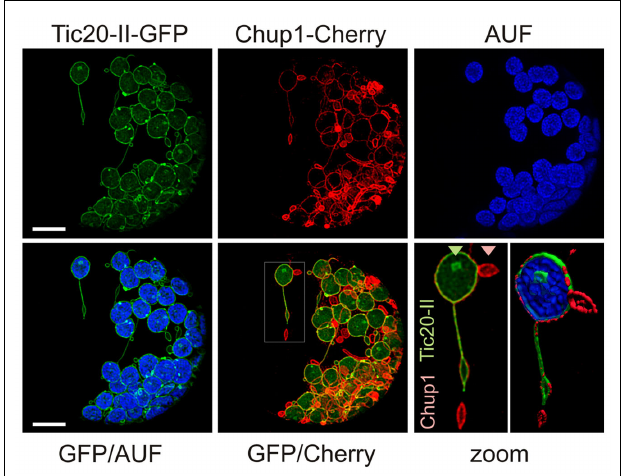
FIGURE 6 | Co-expression of outer and inner chloroplast membrane proteins at high levels induces many types of membrane alterations including stromule-like structures. A. thaliana mesophyll protoplasts were co-transfected with at Tic20-II–GFP (inner envelope) and TM-CHUP1–Cherry (outer envelope; see Figure 5E ). GFP fluorescence (GFP), Cherry fluorescence (Cherry), chlorophyll autofluorescence (AUF) or overlays of GFP/AUF and GFP/Cherry of a representative protoplast are shown. Images are maximum projections of optical sections.The scale bar represents 10 μ m.The framed region in the GFP/Cherry overlay is zoomed in bottom right (scale bare 2 μ m).The triangles point to labeling with GFP or Cherry only. Scale bars represent 10 μ